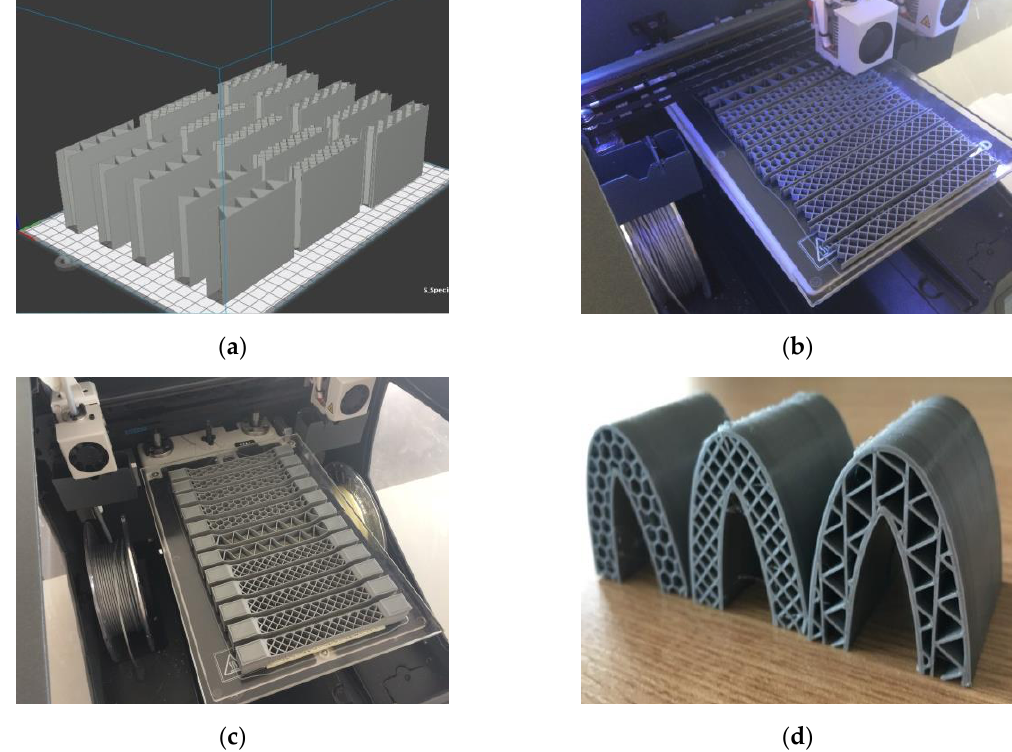
Figure 2. The manufacturing process: ( a ) compression tested specimens; ( b ) three-point bending tested specimens; ( c ) tensile tested specimens; ( d ) the leading edge specimens.